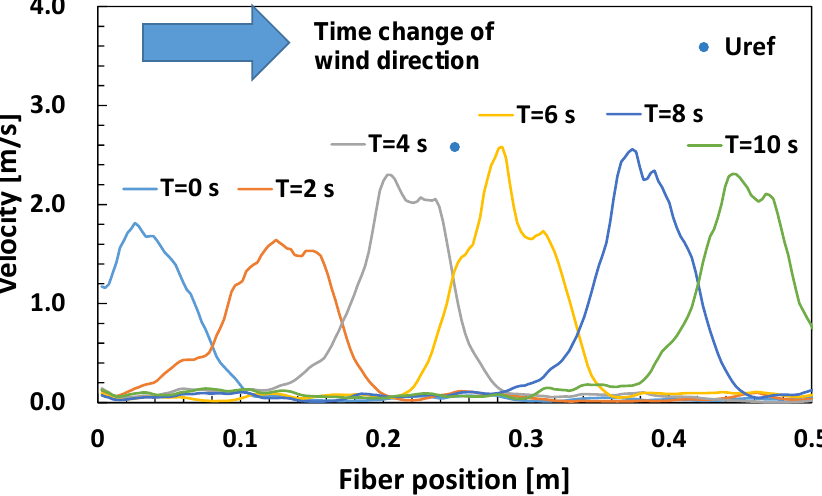
Figure 10. Velocity distribution along the optical fiber in reference to time as snapshots .